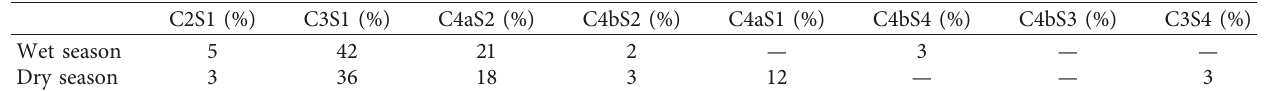
Figure 16: USSR diagram for the study area. Table 5: Irrigation quality of groundwater based on sodium